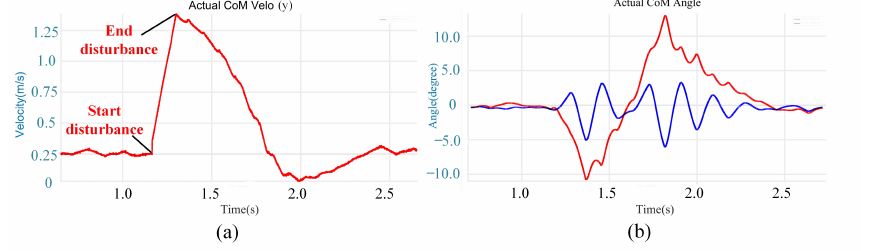
Figure 4. ( a ) Robot body velocity; ( b ) robot body roll and pitch angles. The red line represents the roll angle and the blue line represents the pitch